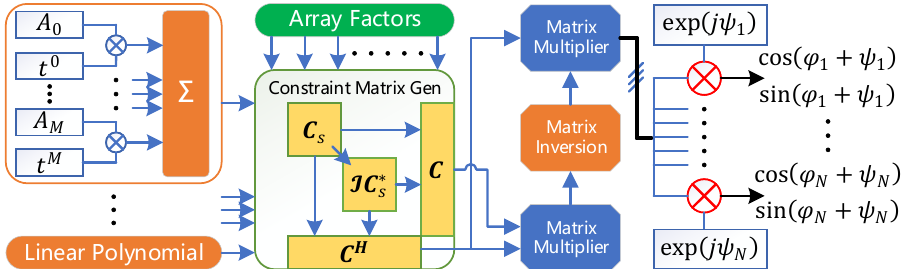
Figure 13. The block diagram of the proposed real-time weight generator for STWE-SAR system.